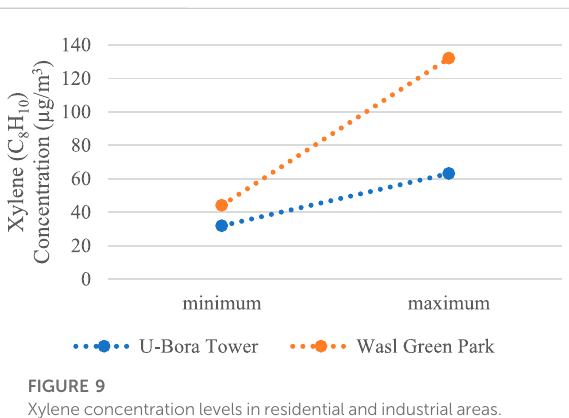
FIGURE 9 Xylene concentration levels inresidential and industrial areas.